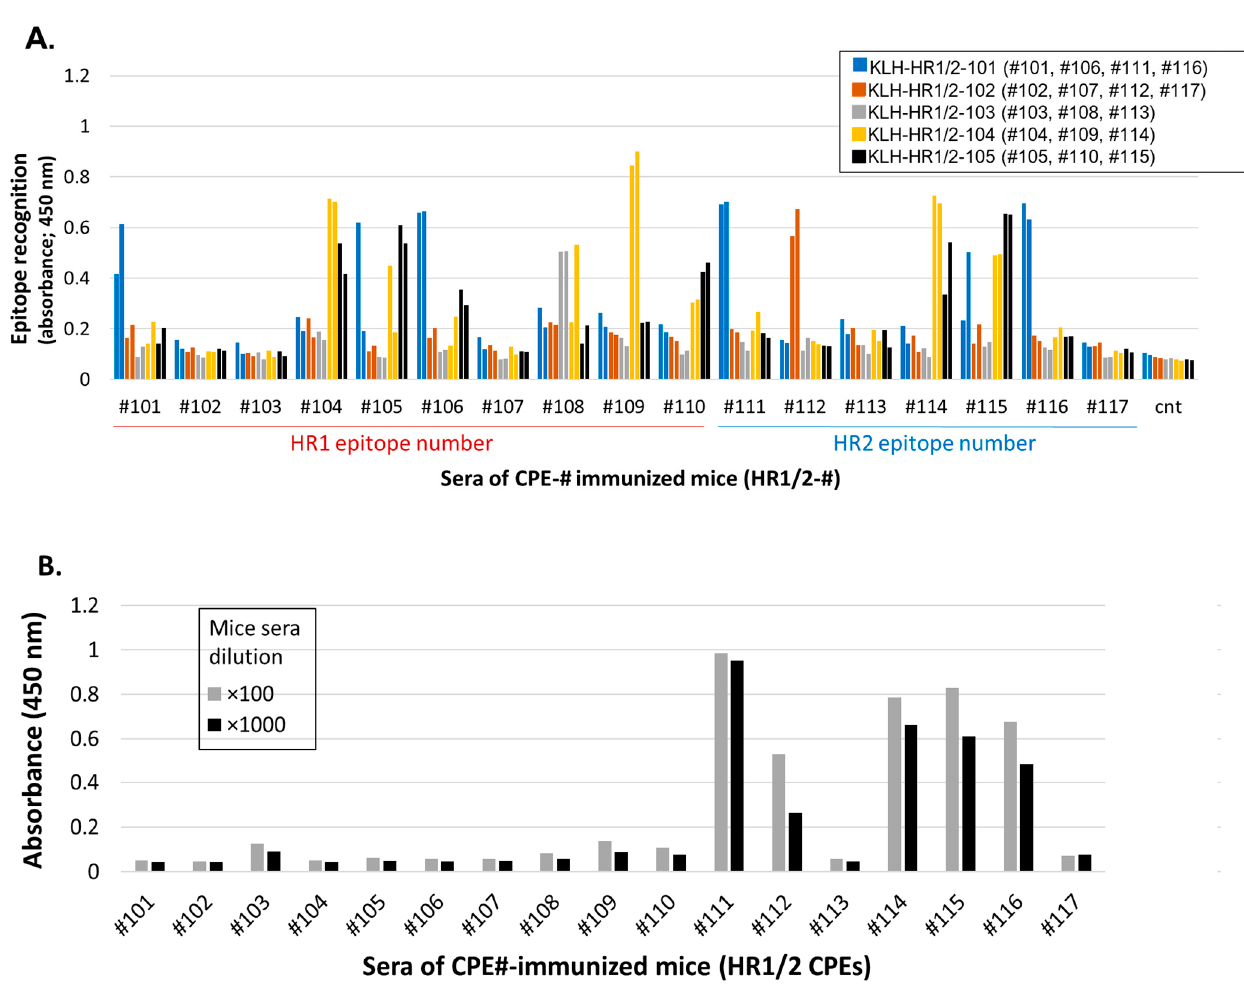
Figure 2. Selection of epitopes in S2-HR1/2 regions in which specific antisera are functional. ( A ) Induction of CPE-specific Antisera in mice immunized with individual S2-HR1/2 CPE-antigens (first trial). The sera of two mice immunized with individual CPE-Ag were evaluated for recognition to CPEs presented on irrelevant carrier protein KLH. The sera dilution was x1000-fold, and positive signals were defined as s/n > 5 compared to the signals of sera of non-immunized mice. ( B ) Assessment of recombinant S2 protein recognition in each CPE-specific Abs. Individual CPE-recognizing Abs were examined for their recognition to recombinant S2 protein. The serial dilutions of mice sera were assessed for binding to S2 protein.